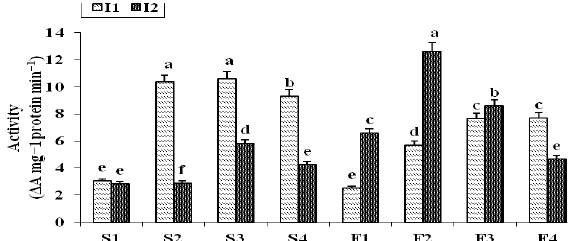
Fig. 3. Changes in polyphenol oxidase activity due to water deficit stress and application of Fe; I1- normal irrigation or irrigation to reach 50% soil moisture depletion of field capacity, I2- irrigation from the beginning of flowering to the end of pollination stage reaching 75% of soil moisture depletion of field capacity; S- soil application of Fe, S1- without soil application of Fe; S2- 50 Fe Kg ha -1 , S3- 100 Fe Kg ha -1 , S4- 150 Fe Kg ha -1 ; F- foliar application of Fe, F1- foliar application of water, F2- 1,000 Fe mg l -1 , F3- 2,000 Fe mg l -1 , F4- 3,000 Fe mg l -1 ; LS MEANS within each column of each section followed by the same letter are not significantly different (p ≤ 0.05)